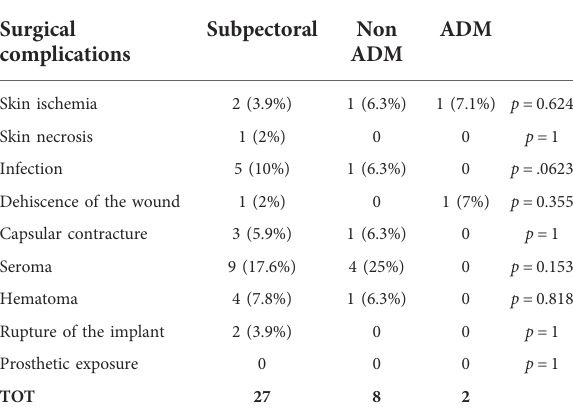
TABLE 2 Surgical